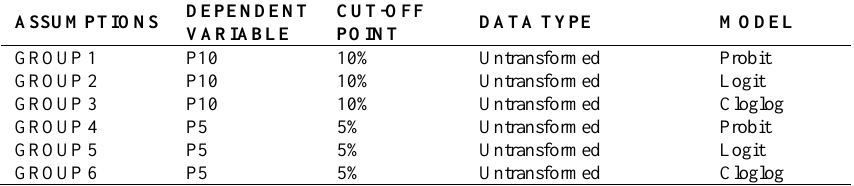
Table 16. Six the best combinations of the state of turbulence models